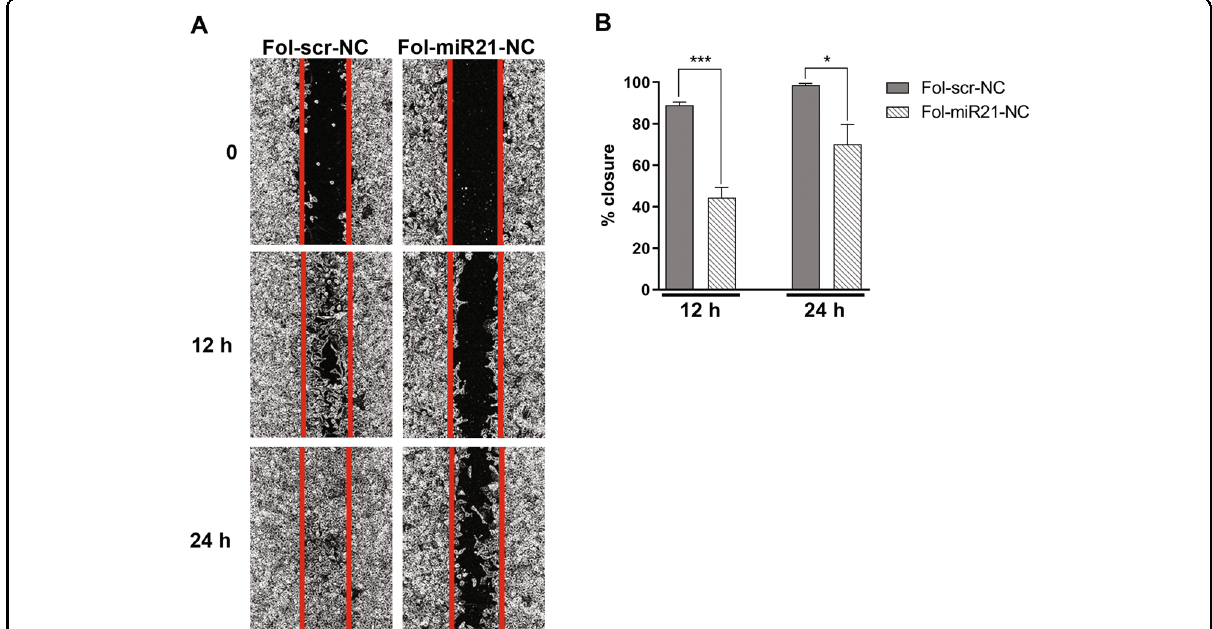
Fig. 5 MiR-21 silencing inhibits migration of HeLa cells. A In vitro wound-healing assay on cell migration across the scratched area was monitored for 24 h. Images converted to grayscale are shown. B Histograms represent the relative percentage of distance covered by cells 12 and 24 h after scratch (% closure). Values reported were obtained as mean ± S.E.M. of three different experiments. Statistical signi fi cance: * P < 0.05 and *** P < 0.001 (Student ’ s t